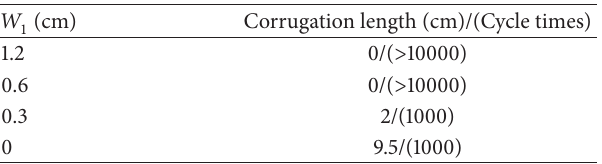
Table 2: Corrugation failure length versus cycle times associated with four different SPS